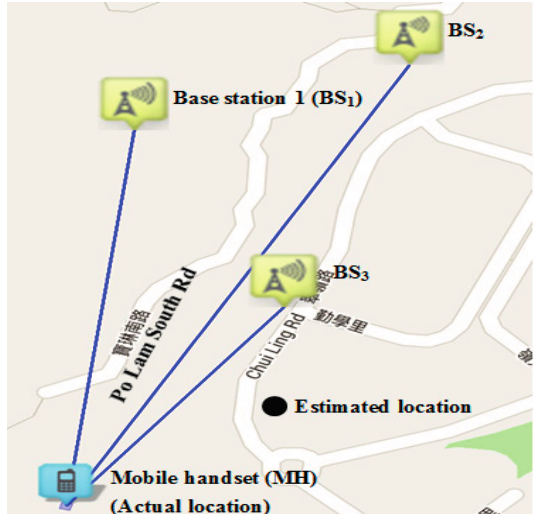
Figure 2. Localization experiment using new noise model (3) in a residential area in Hong Kong with variance ~10, percentage improvement = 10%.